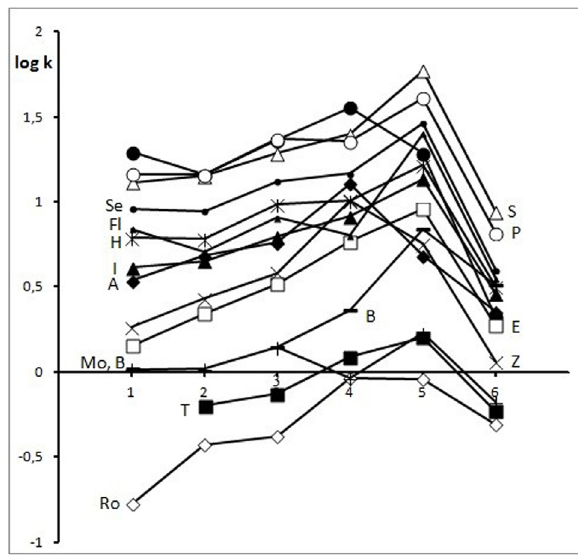
Figure 1: Graphical comparison of log k values of the psychotropic drugs on different columns with mobile phases containing as eluent 55% methanol, 20%acetate buffer at pH 3.5 and 0.025 ML -1 DEA obtained on 1. C18, 2. Phenyl, 3. Phenyl-Hexyl, 4. Polar RP, 5. PFP and 6. CN columns.